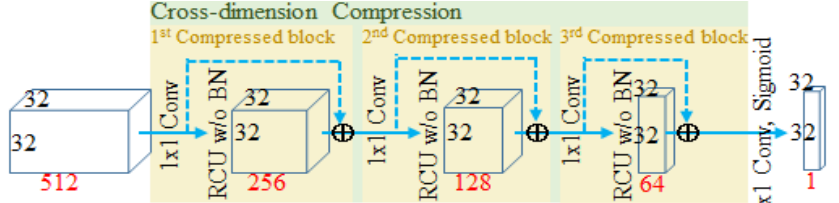
Figure 10. CDC stage in the first stage as an